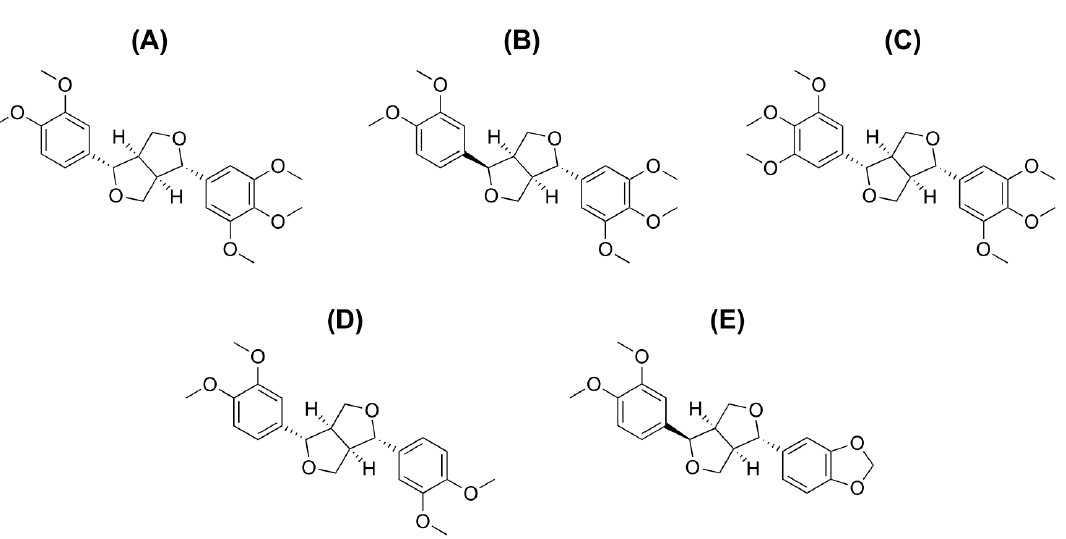
Figure 1. Chemical structures of ( A ) magnolin, ( B ) epimagnolin A, ( C ) dimethyllirioresinol, ( D ) eudesmin, and ( E ) fargesin.